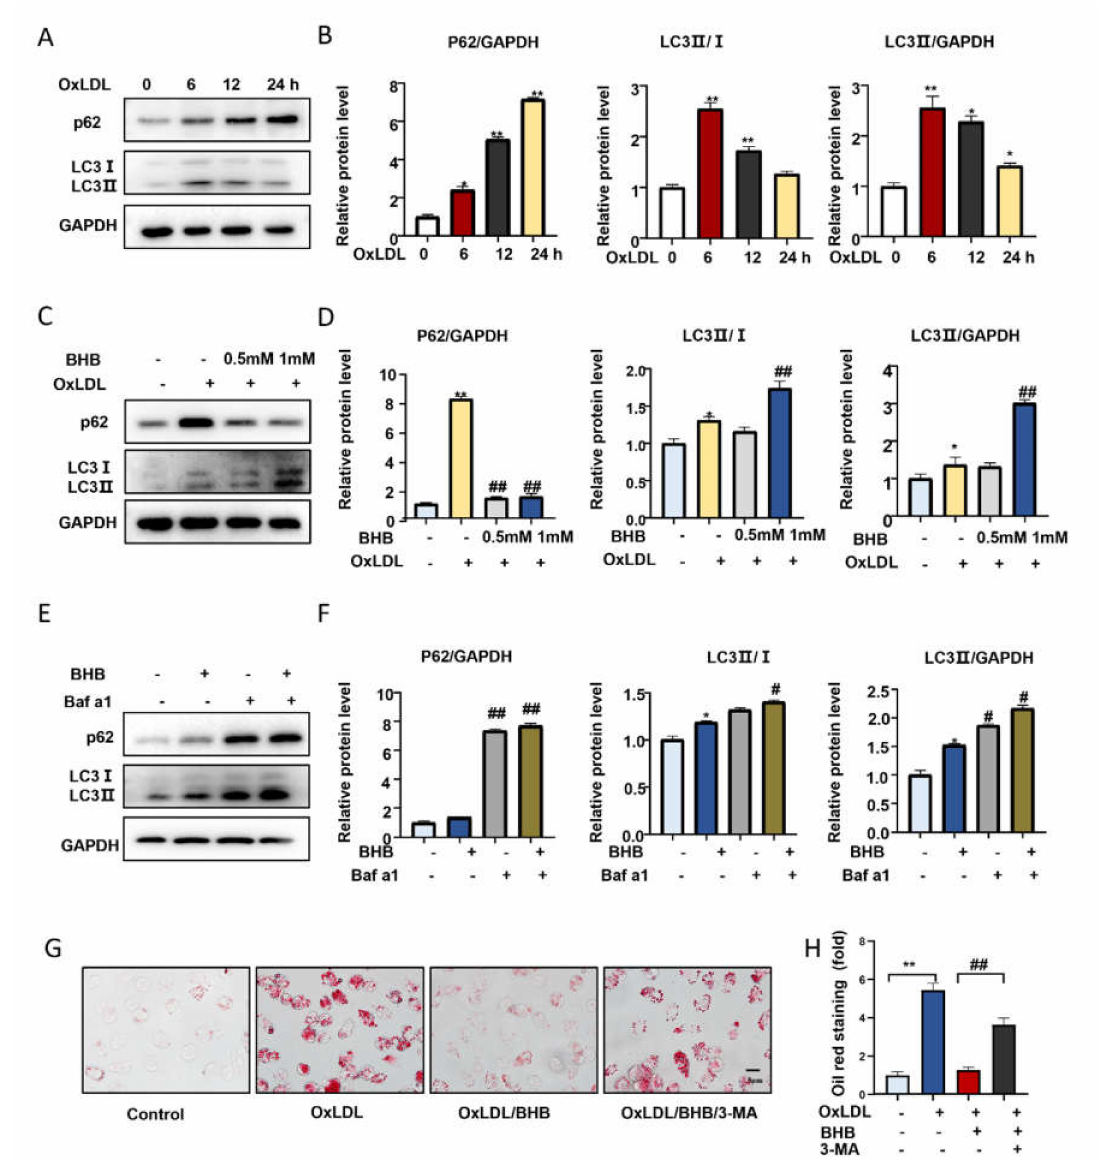
Figure 4. BHB ameliorates autophagy in vitro. ( A , C , E ) Western blot analysis of p62 and LC3 protein levels in PMs. ( A ) Western blot analysis of the expression of p62 and LC3 in PMs pretreated with or without OxLDL (50 µ g/mL) for 6 h, 12 h, and 24 h. ( C ) Western blot analysis of the expression of p62 and LC3 in PMs pretreated with or without OxLDL (50 µ g/mL) for 24 h and treated with BHB (0.5 mM, 1 mM) for 24 h. ( E ) Expression of p62 and LC3 in PMs pre-incubated with Baf a1 (200 nM) for 6 h before treatment with BHB (1 mM). ( B , D , F ) Quantification of relative protein levels (n ≥ 3). ( G ) Oil Red O staining of PMs in the presence or absence of OxLDL (50 µ g/mL), BHB (1 mM), or 3-MA (1 mM) for 6 h. Scale bars, 5 µ m. ( H ) Quantification of Oil Red O staining (n = 6). * p < 0.05, ** p < 0.01 vs. control; # p < 0.05, ## p < 0.01 vs. OxLDL-treated group or BHB-treated